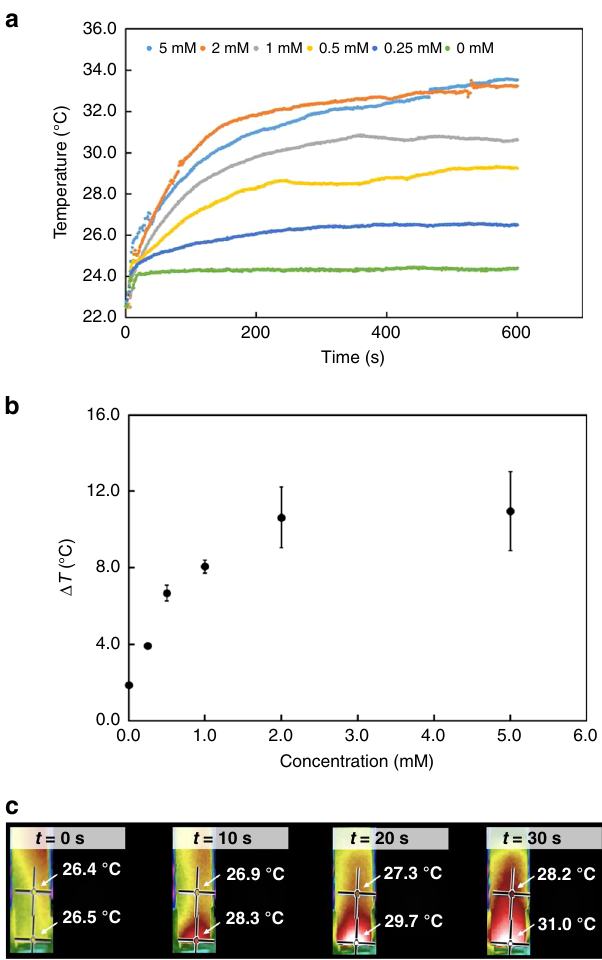
Fig. 3 Photothermal temperature changes due to DASA-CF 3 -PI in solution. a Average heating of chloroform solutions with varying concentrations of DASA-CF 3 -PI using 214 mW cm − 2 white light. b Change in temperature as a function of DASA-CF 3 -PI concentration from t = 0 s to t = 600 s. Average values are plotted with error bars calculated from the standard deviation of replicate measurements ( N = 3). c Thermal images of heat gradient established in the fi rst 30 s of irradiation of 2 mM DASA-CF 3 - PI in chloroform, as measured with an IR camera. Note, the camera ’ s auto- adjust feature prevents the use of a consistent legend for the temperature, so numeric values for two locations are